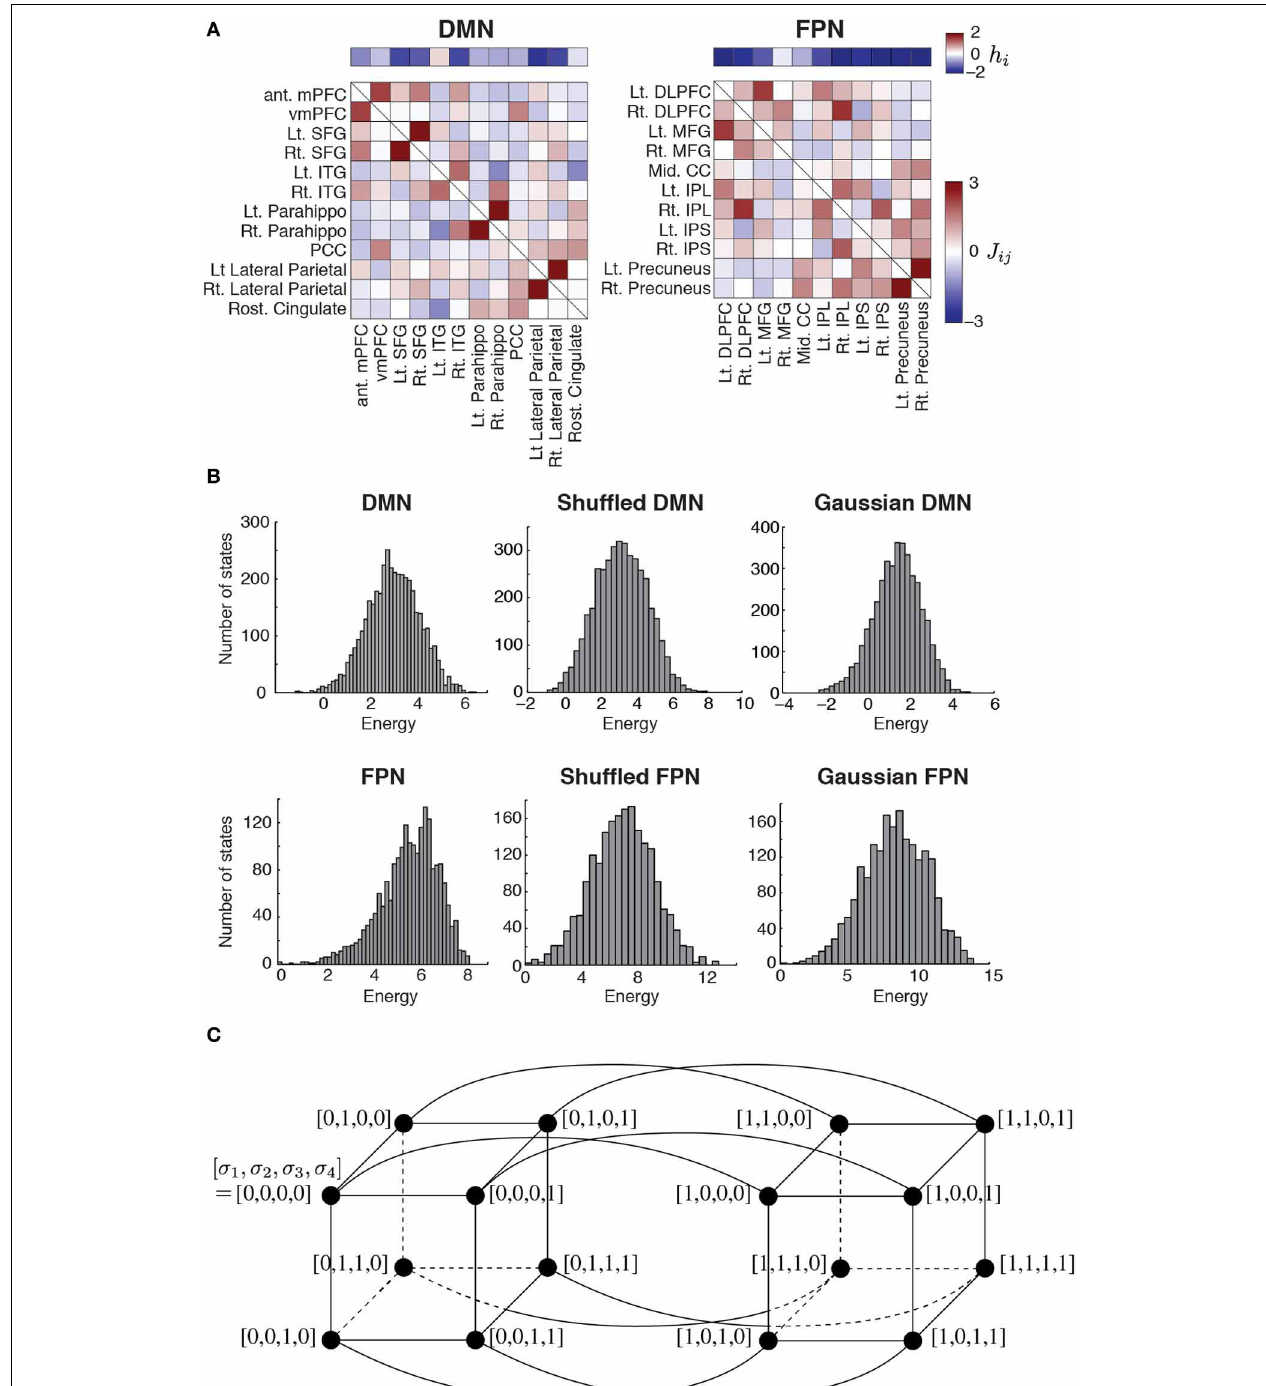
FIGURE 1 | (A) Parameter values estimated for the two RSNs. The horizontal bars show the basal brain activity ( h i ). The square matrices show the functional connectivity between pairs of regions ( J ij ) as determined by the fitting of the pairwise MEM. The obtained parameter values were identical to those obtained in our previous study (Watanabe et al., 2013). DMN, default mode network; FPN, fronto-parietal network; ant mPFC, anterior medial prefrontal cortex; vmPFC, ventro-medial prefrontal cortex; Lt, left; Rt, right; SFG, superior frontal gyrus; ITG, inferior temporal gyrus; Parahippo, parahippocampal gyrus; PCC, posterior cingulate cortex; DLPFC, dorso-lateral